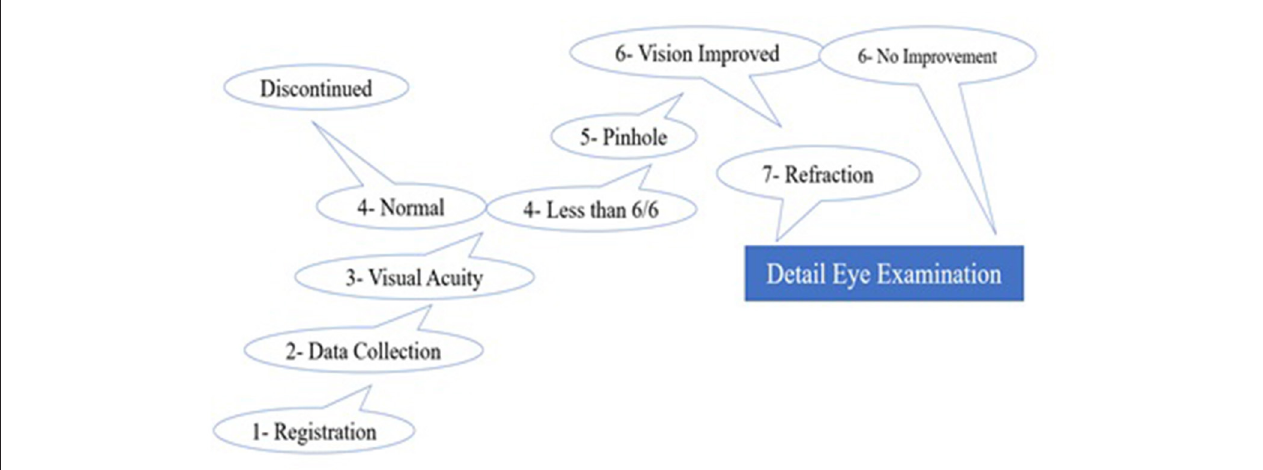
FIGURE 2 | Schematic diagram of the screening protocols for measurement of refractive errors at